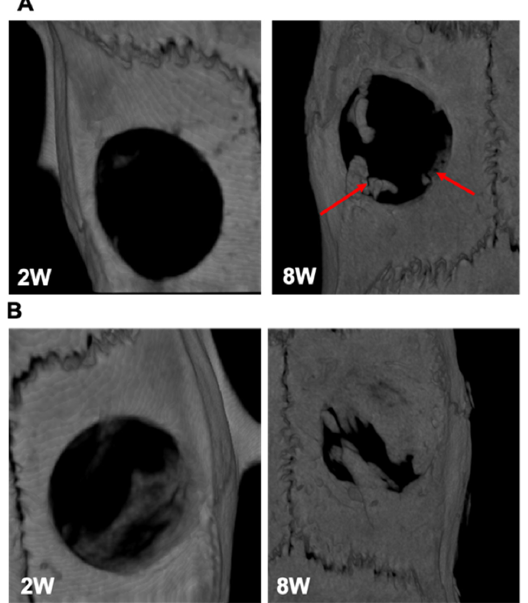
Figure 8. Calvaria bone defect regeneration. ( A , B ): MicroCT results following implantation of DC-WJ and DV-WJ, respectively. The two weeks (2 W) scans were obtained in vivo (35.8 µ m) while eight weeks (8 W) scans were obtained ex vivo (17.9 µ m). Red arrows indicate marginal bone regeneration in the presence of